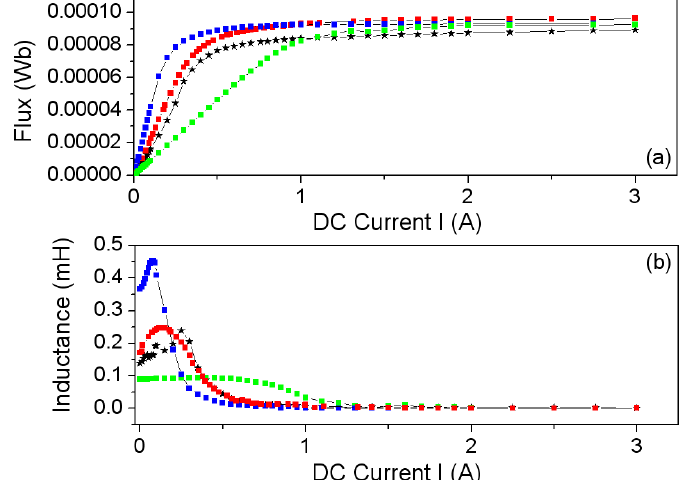
Figure 9. ( a ) Φ - I curves and ( b ) L - I curves computed by experiment (–  –) and 2D simulations for g = 0 (–  –), 5 (–  –), and 20 µm (–  –).